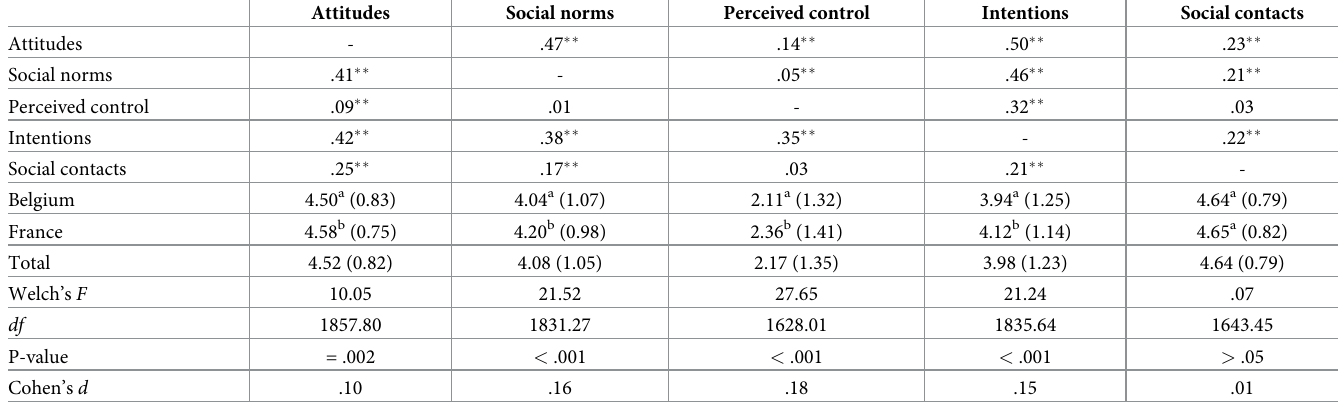
Table 3. Correlation matrix with Belgian above and French below, means and standard deviations for limitation of social